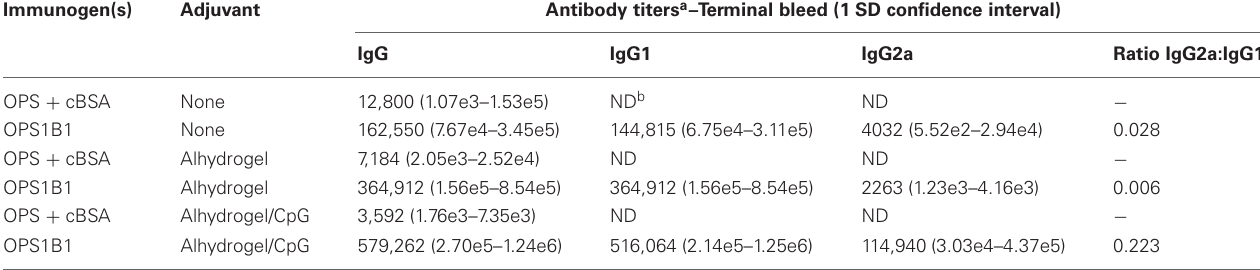
Table 2 | Effect of adjuvants on serum immunoglobulin responses.